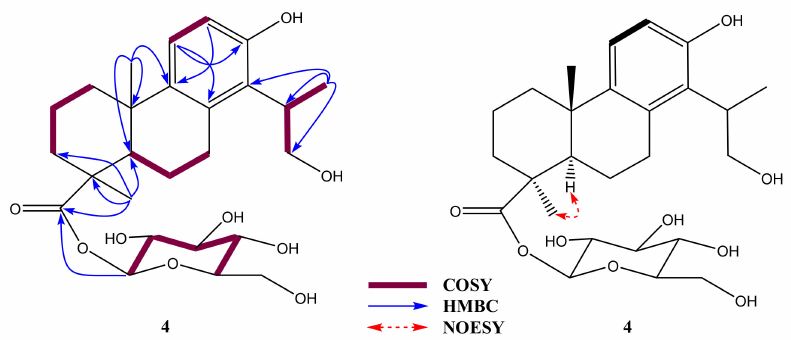
Figure 2. 1 H- 1 H COSY, 1 H- 13 C HMBC, and 1 H- 1 H NOSEY correlations of compound 4 .